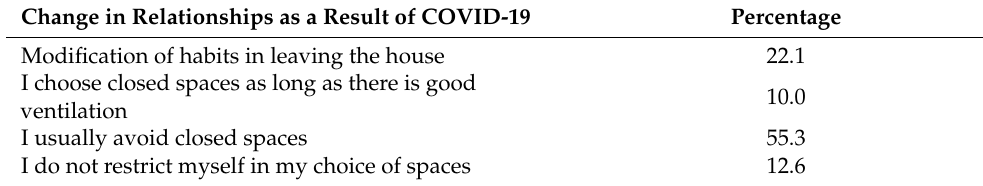
Table 4. Distribution (in percentages) of the change in leaving the